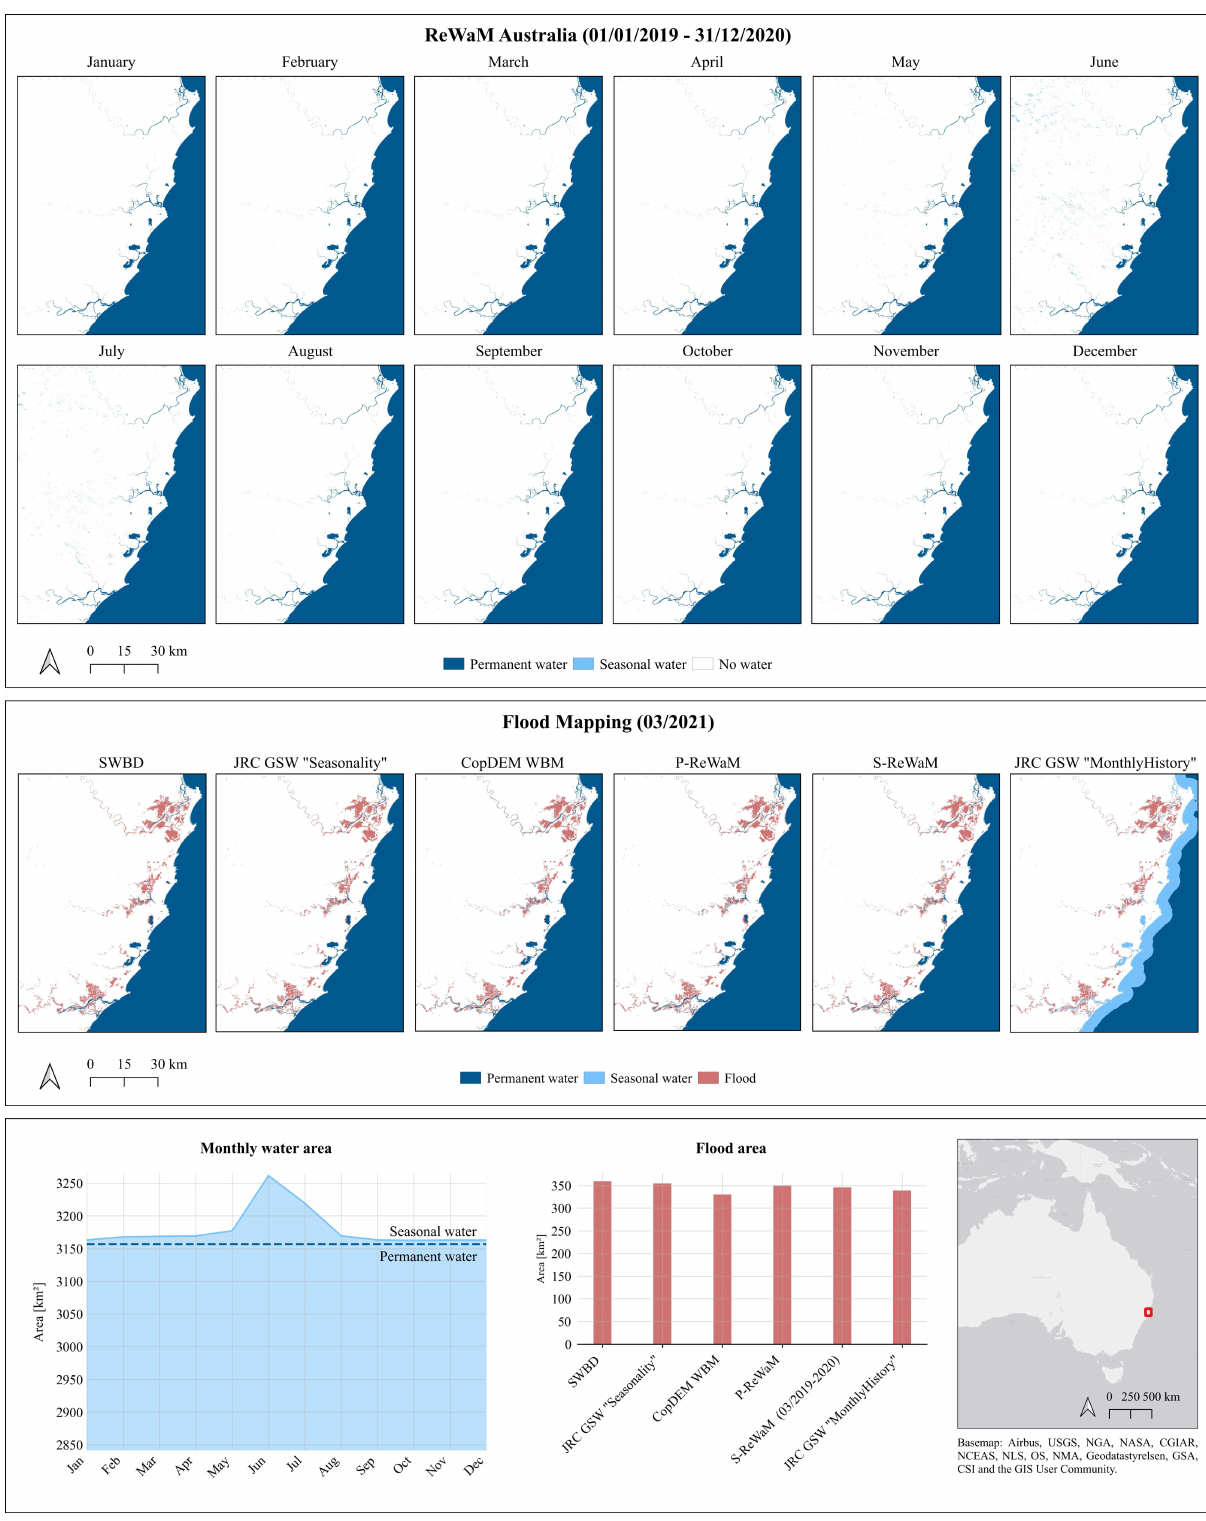
Figure 3 . Reference water extents of P-ReWaM and S-ReWaM for the study area in Eastern Australia, derived from Sentinel-1/2 time-series data (observation period: 01/01/2019-31/12/2020). Comparison of flood mapping results in Australia using P-ReWaM and S-ReWaM with external reference water masks; flood extents are derived from Sentinel-1 data acquired during a real flood event in March 2021. The S-ReWaM of the month March is used as seasonal reference water mask. Corresponding flood extents are visualized as bar